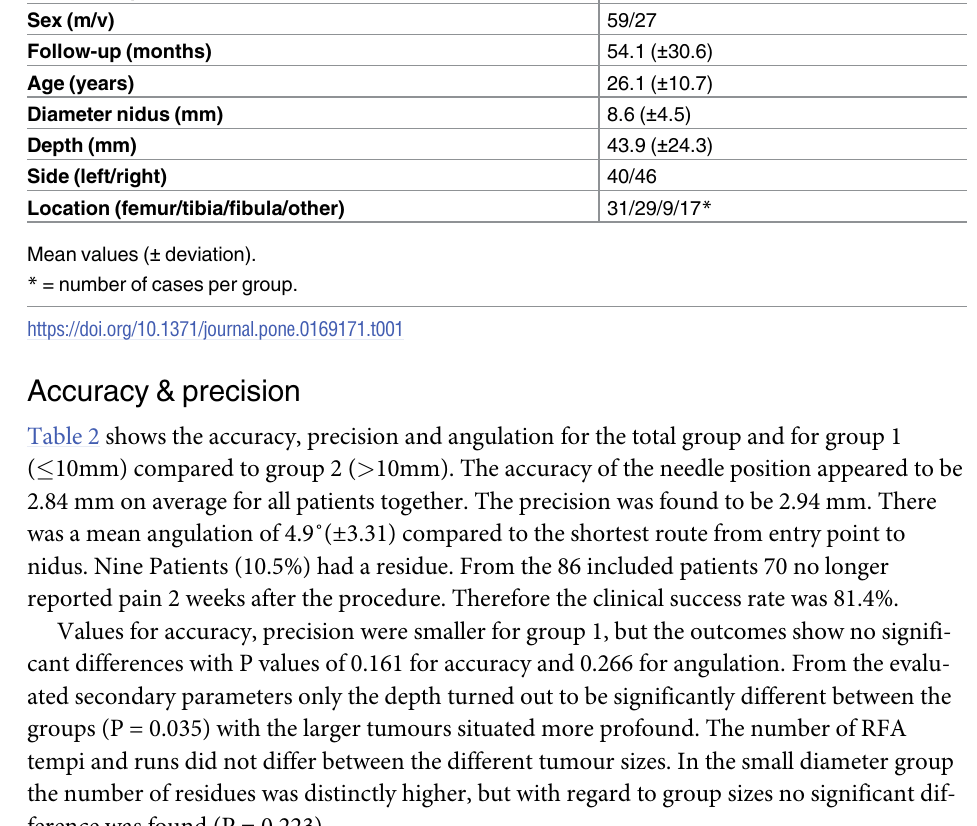
ference was found (P = 0.223). needle and tumour (i.e. the accuracy) differs between the locations (P = 0.018) although non-